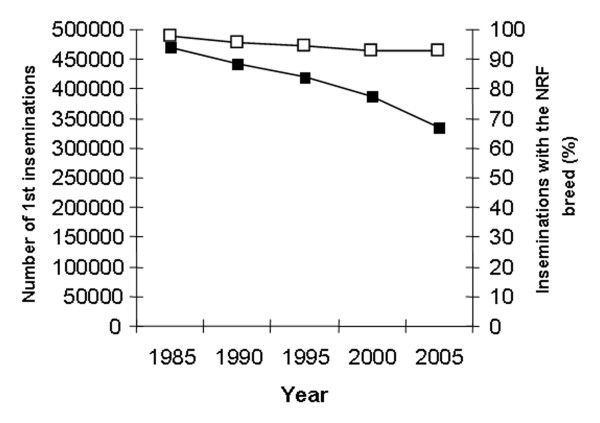
Total number of first inseminations (■) and percentages of inseminations performed with semen from bulls of the NRF breed (□) every 5th year from 1985 to 2005.